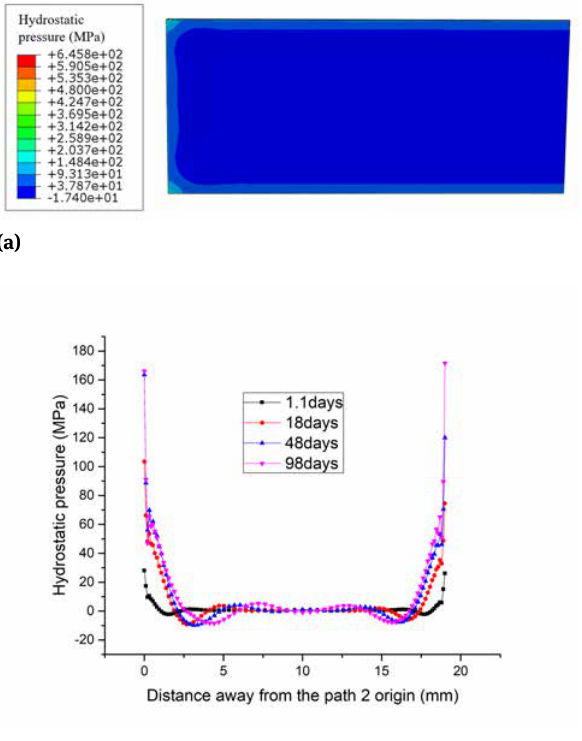
Figure 20: (a) The contour plot of the hydrostatic pressure on the 98 th day in the fuel meat; (b) the evolution history of the hydrostatic pressures along Path